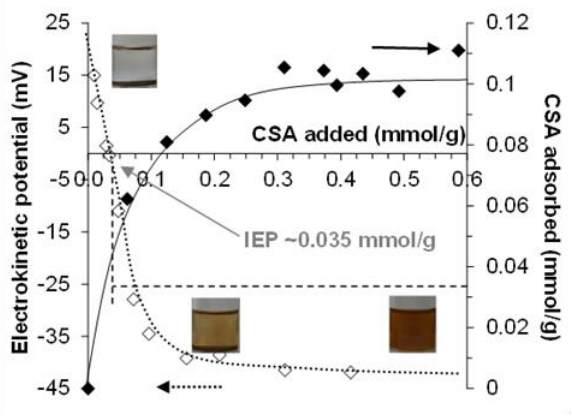
Figure 5. Effect of CSA-addition on the charge state of MNPs and the colloidal stability of the dispersions (inserted photos) at pH ~6.3 and 10 mM NaCl. The adsorption and the electrokinetic potential data are shown. (Lines are drawn as guides for the eye).